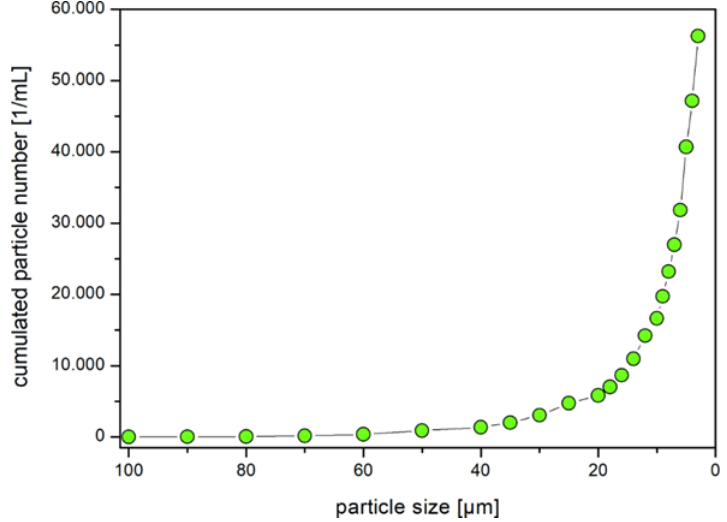
Figure 1. Size distribution of the used polystyrene microplastic particles (PS MP).